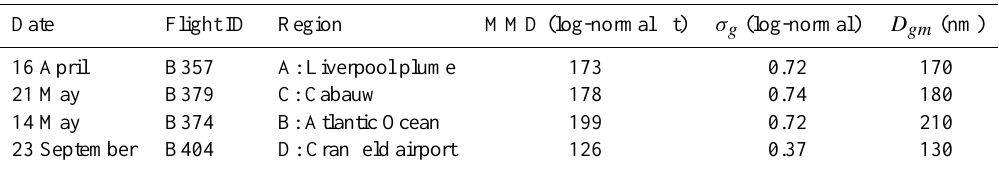
Table 4. Summary of regionally-averaged refractory black carbon (rBC) mass distribution statistics. MMD refers to the mass median diameter of the log-normal fit to the average size distribution, σ g is the width of the log-normal fit, and D gm is the average mass mean diameter calculated from Eq. (1). Regions are identified in Fig.